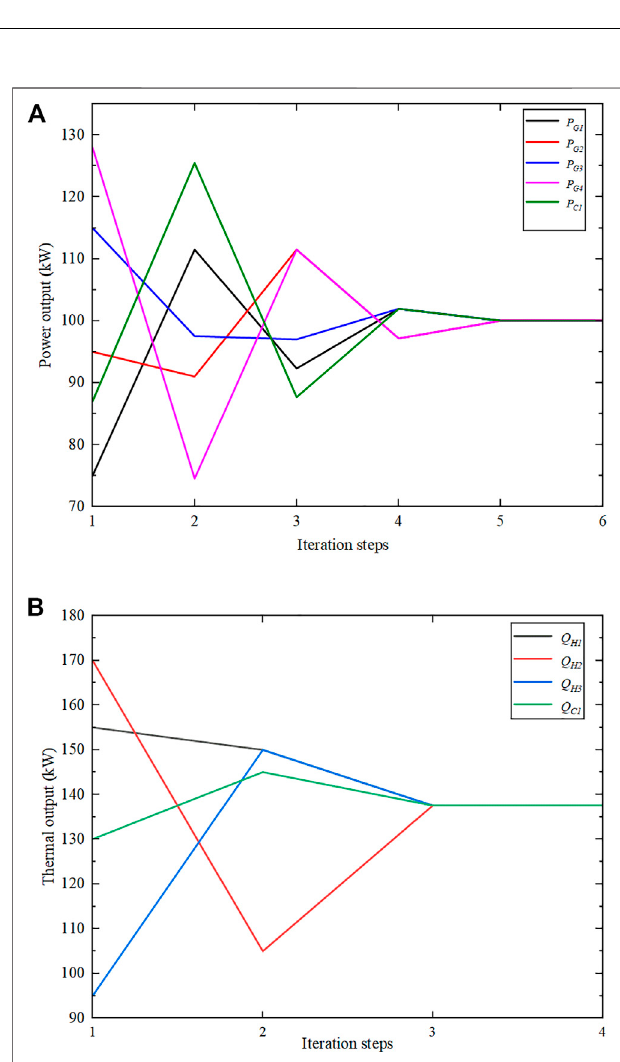
FIGURE 4 | Total output power iterative process. (A) Electrical power output. (B) Thermal power